Question: Which kind of chart has been used to present this data?
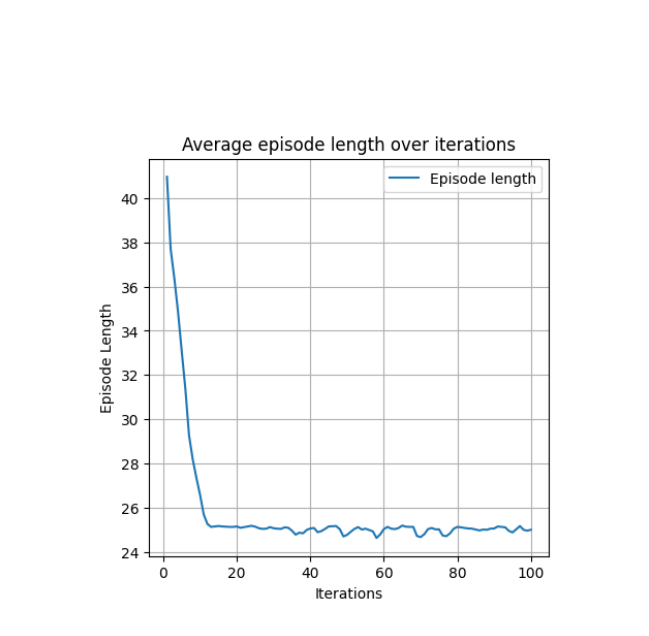
Answer: line